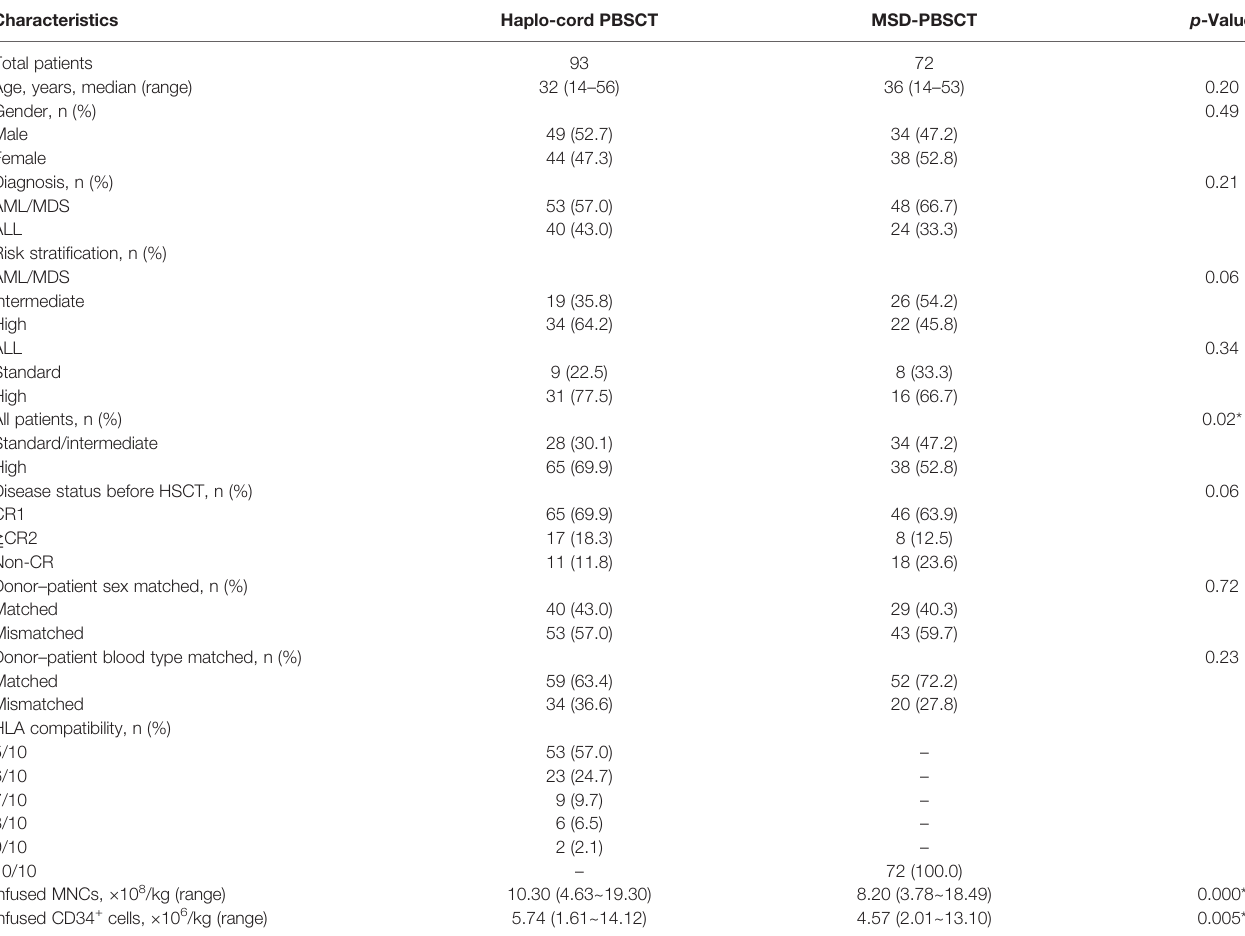
TABLE 1 | Patient and graft